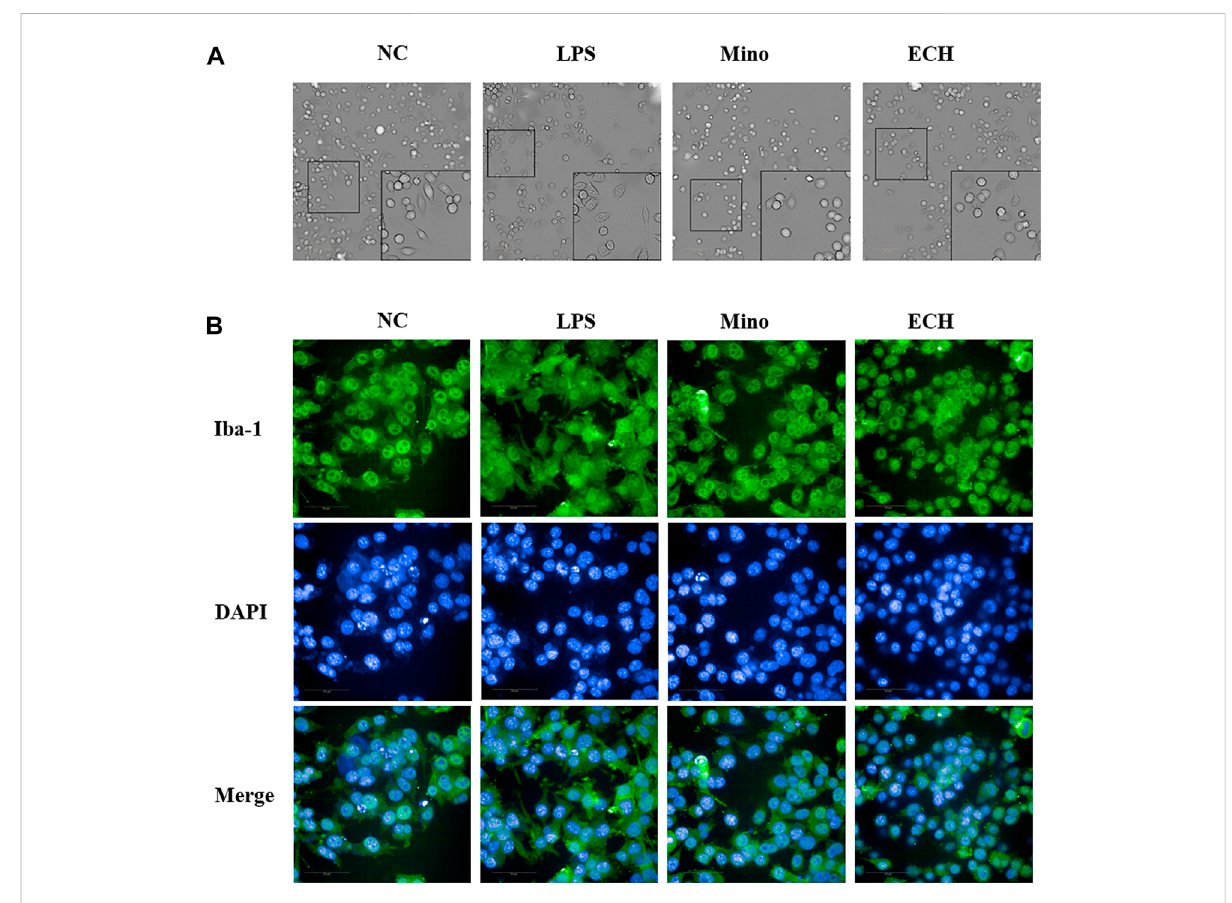
FIGURE 10 Effects of ECH on morphology (A) and Iba 1 expression level (B) in LPS-induced N9 cells. NC, treated with equal amounts of medium; LPS, treated with1 μ g/mL LPS; Mino, treated with 1 μ g/mL LPS and .1 μ M minocycline; ECH, treated with 1 μ g/ml LPS and 20 μ M echinacoside. n = 3/ group. * p < .05, ** p < .01 compared with control